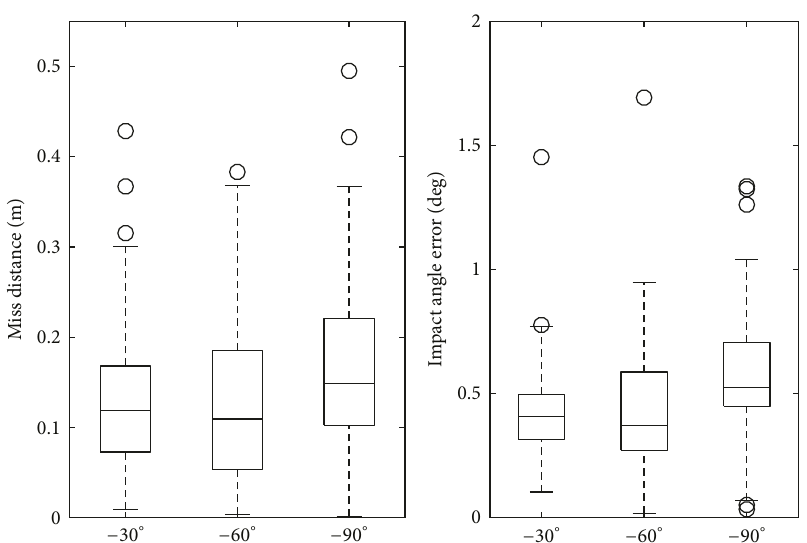
Figure 5: Distributions of errors under different impact angle constraints.